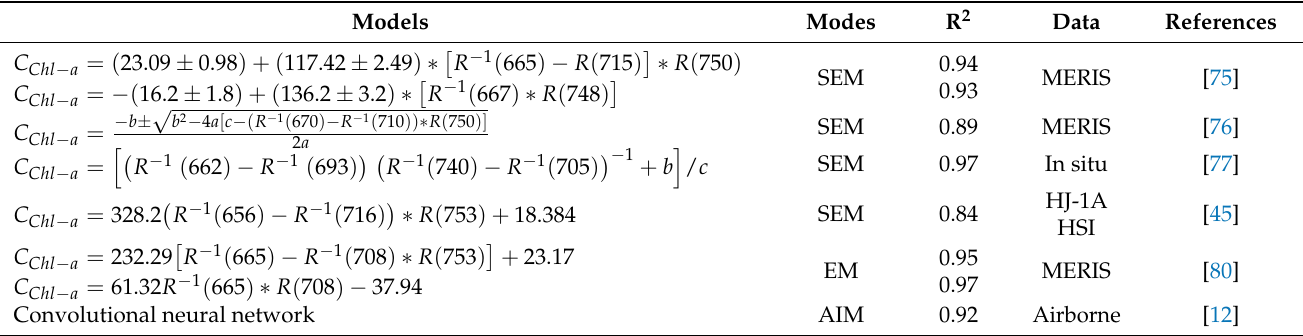
Table 3. Inversion models of Chl– a concentration. Models